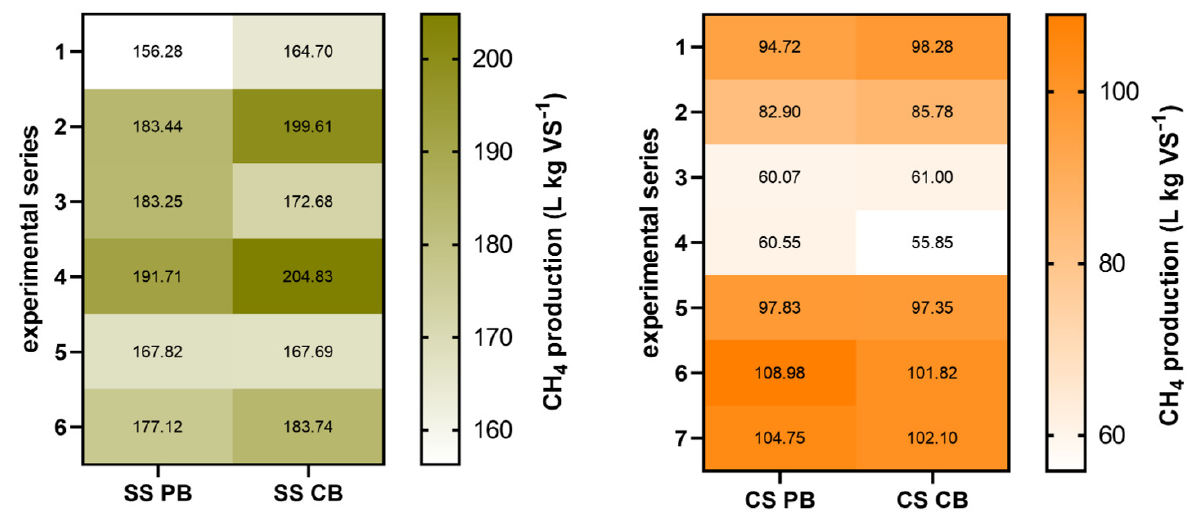
Figure 1. Heatmap presenting average methane production (L kg VS − 1 ) in each experimental series in process (PB) and control bioreactors (CB) containing sewage sludge (SS) and cattle slurry (CS).